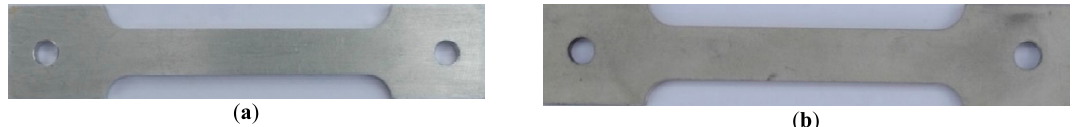
Figure 3. Images of samples for stress corrosion tests of AlMg6 alloy with sheet thickness g = 6 mm, ( a ) without coating, ( b ) with coating.